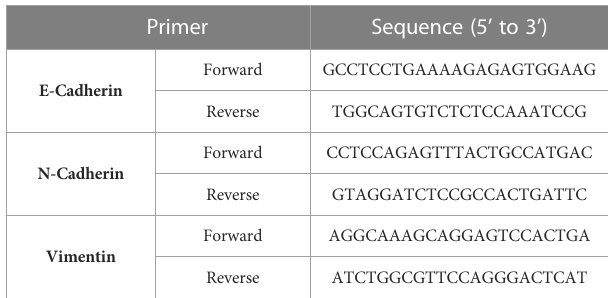
TABLE 1 The primer sequence of EMT